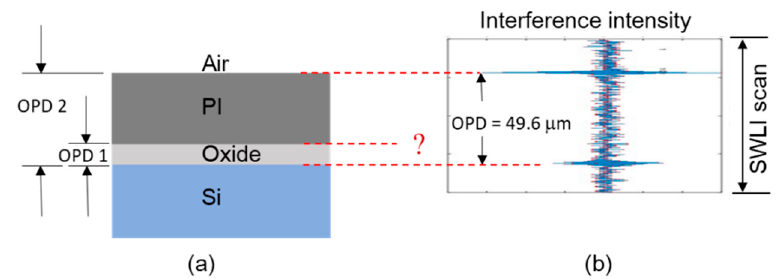
12 of 16 Figure 11. ( a ) Simulation model of the PI layer on the BGA sample; the silicon substrate has an insulating oxide layer above and a PI layer on top. The physical thicknesses of the PI and oxide are 𝑡 (cid:3017)(cid:3010) and 𝑡 (cid:3042)(cid:3051) respectively. ( b ) Top: simulation interference spectrum of each pair of reflecting lights A, B, and C. Bottom: Fitting of the combined reflectance spectrum (A + B + C) with the experimental reflectance. The fitting results were 𝑡 (cid:3017)(cid:3010) = 25.34 μ m and 𝑡 (cid:3042)(cid:3051) = 5.31 μ m. 5.2.2. Comparison of PL Measurement with Scanning White Light Interferometry We used a Mirau-type scanning white light interferometer (SWLI) to verify the thick- ness of the semitransparent films measured by the reflectometer as described in Section 5.2.1 and shown in Figure 12a. The SWLI system translated vertically so that the surfaces of the upper and lower films passed through the focus. For each location in the field of view, two sets of interference fringes developed during the scan: one corresponding to the